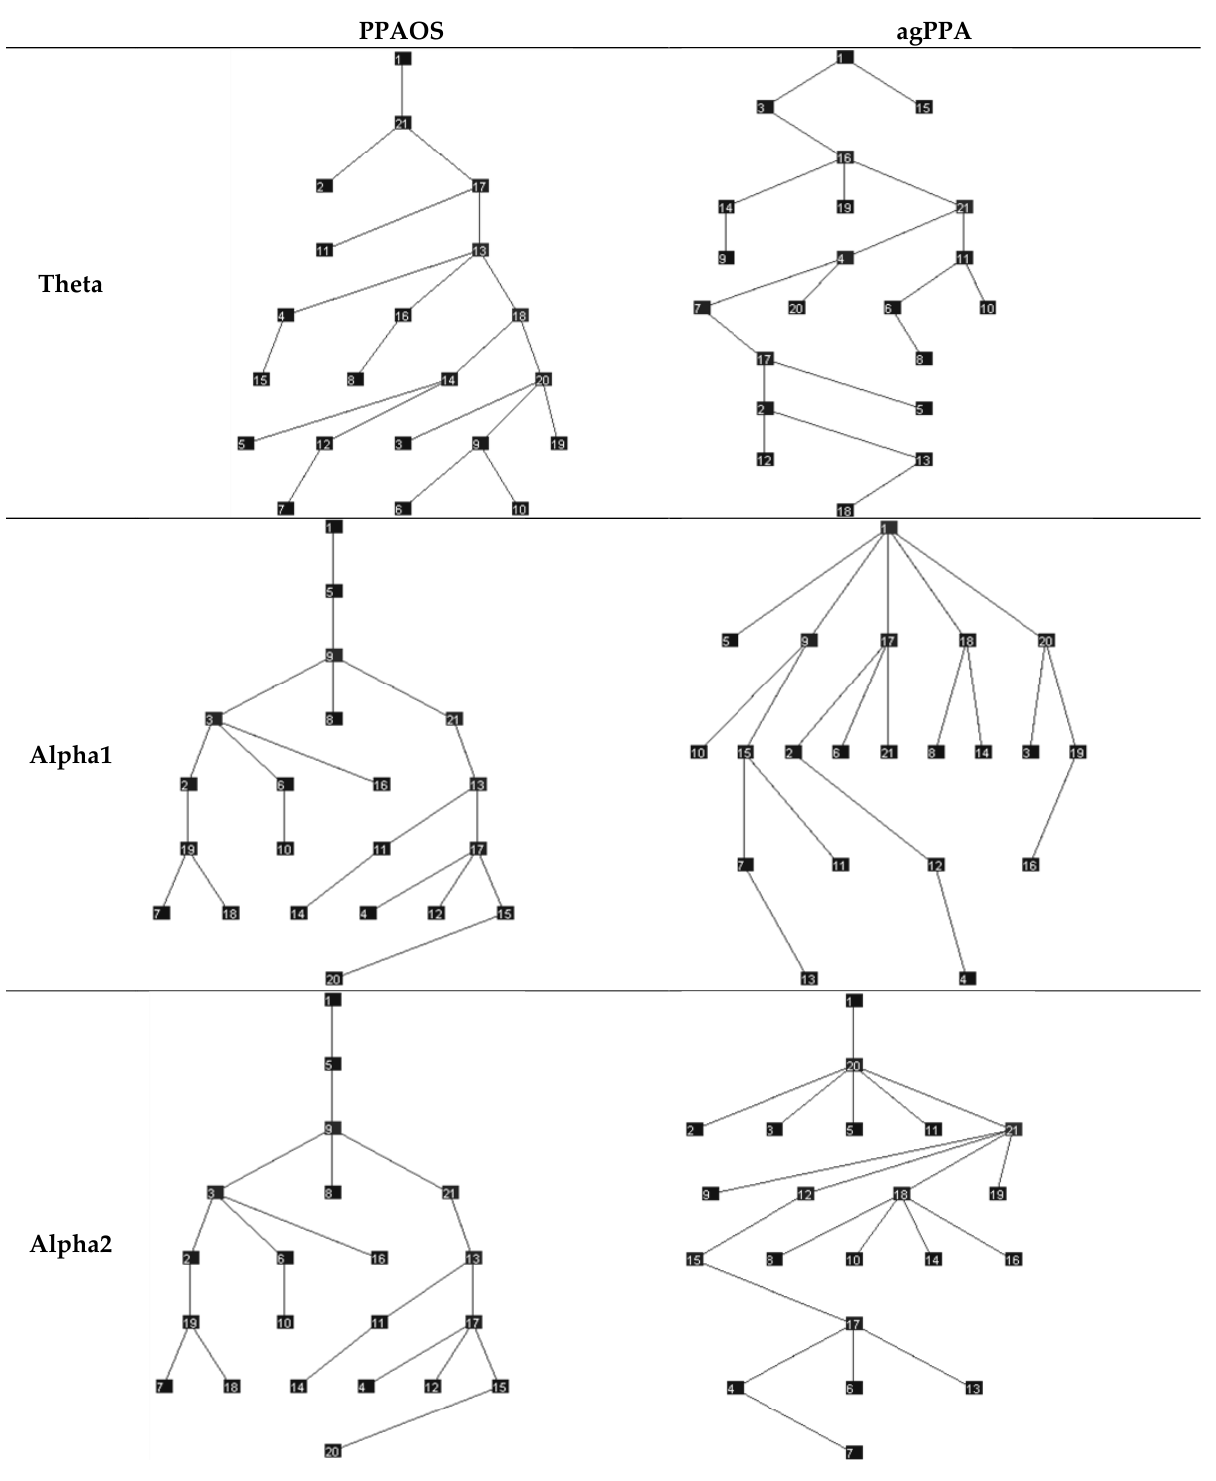
Figure 4. Minimum Spanning Trees (MSTs) separating the agPPA patients and PPAOS, for the theta, alpha1, and alpha2 frequency bands. This visualization connects all nodes, maximizing synchronization. The numbers reflect electrode numbers; consistent with assessing mean connectivity, the relationships between specific electrodes were not explored in this study.